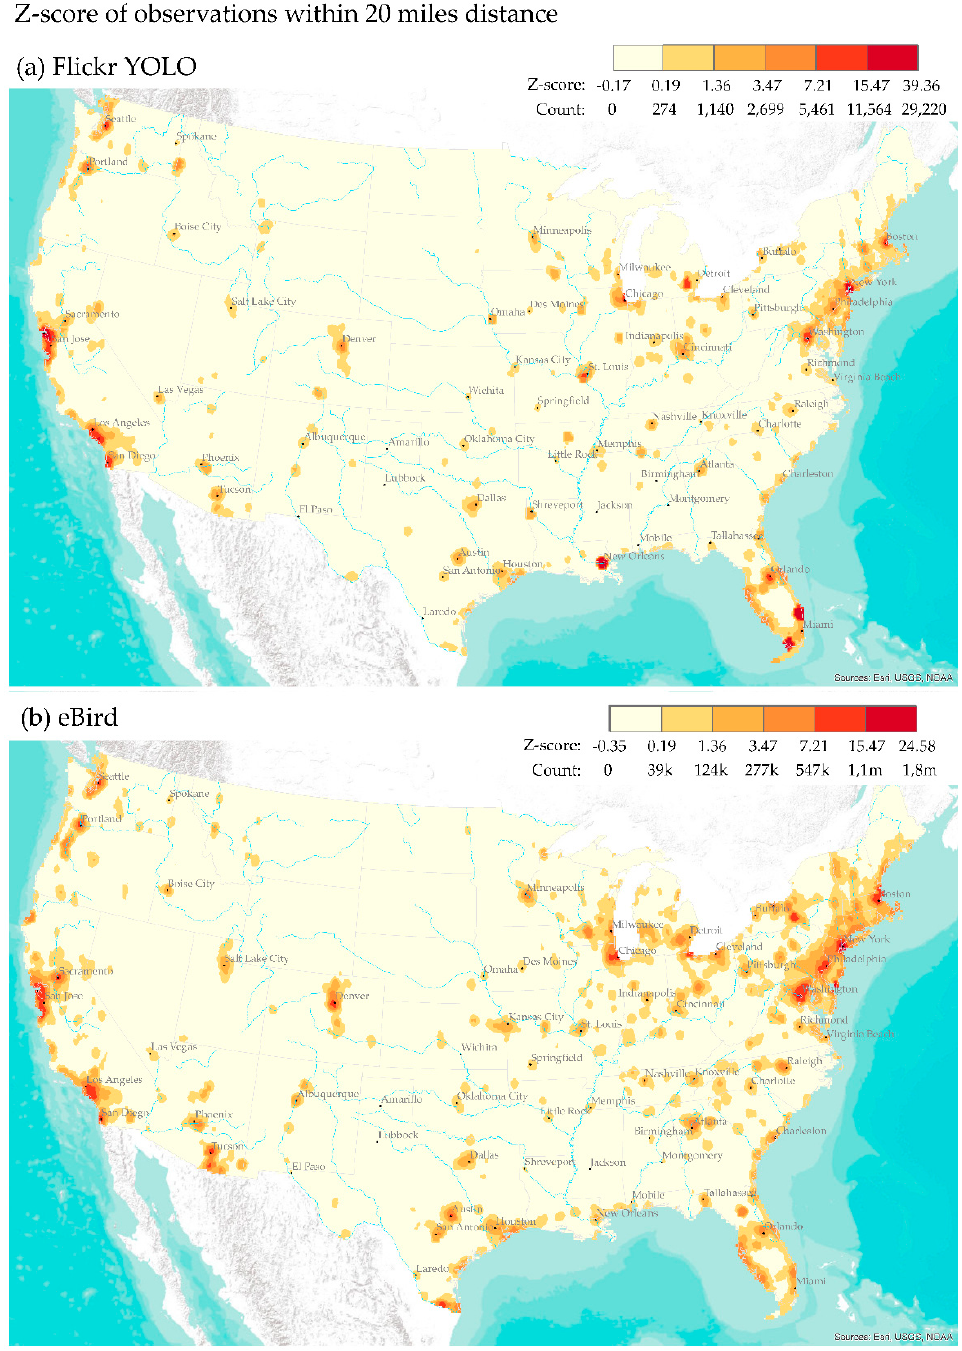
Figure 8. Z-scores of the fixed-distance (20 miles) density of ( a ) YOLO-detected Flickr bird image and ( b ) eBird observations.